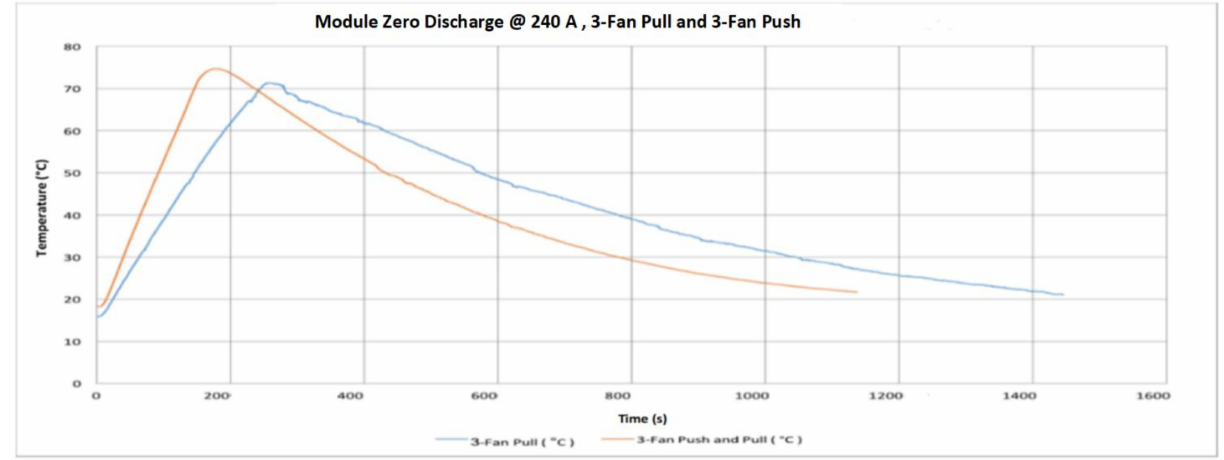
Figure 15. Module zero discharge, 240 A 3-fan pull and 3-fan push